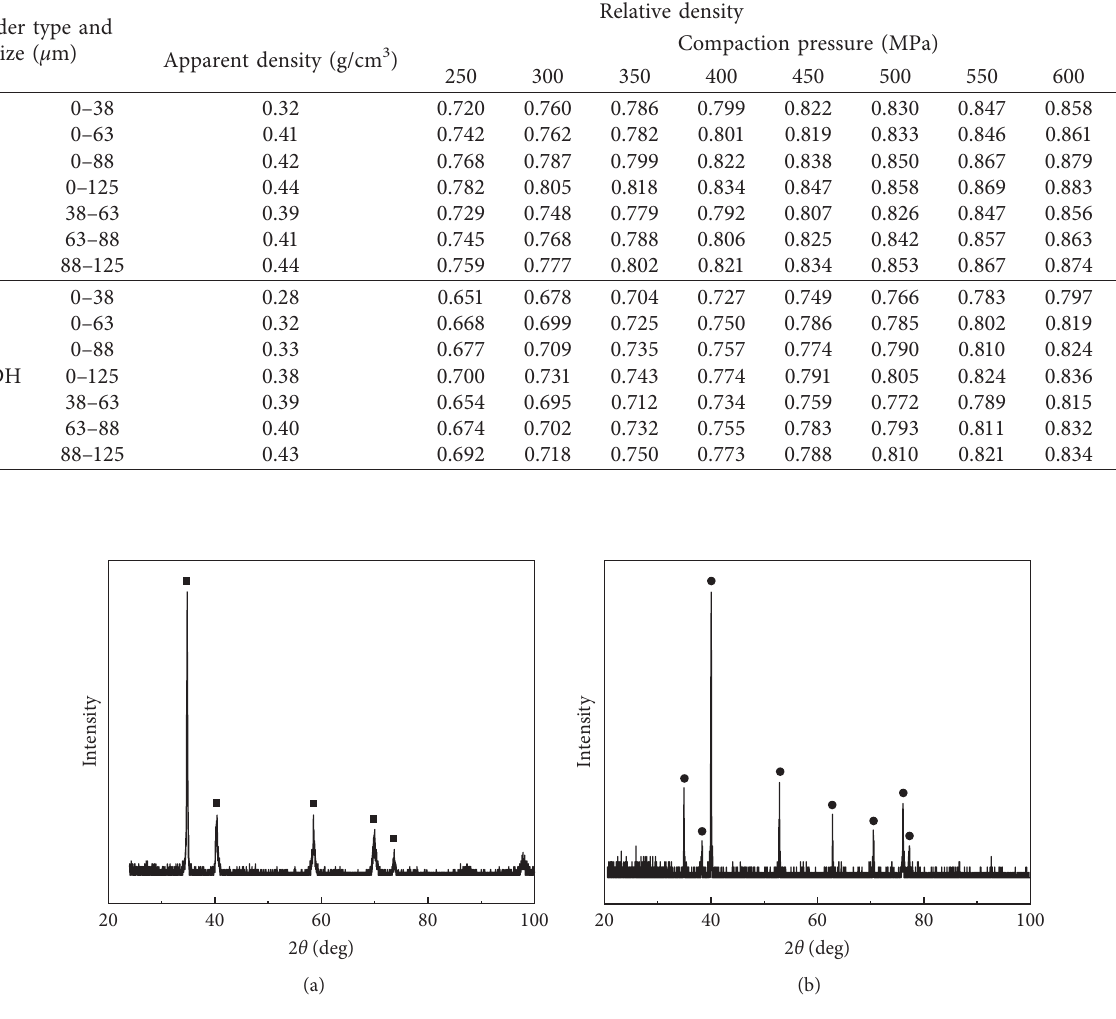
2 and (b) Ti HDH. Compaction